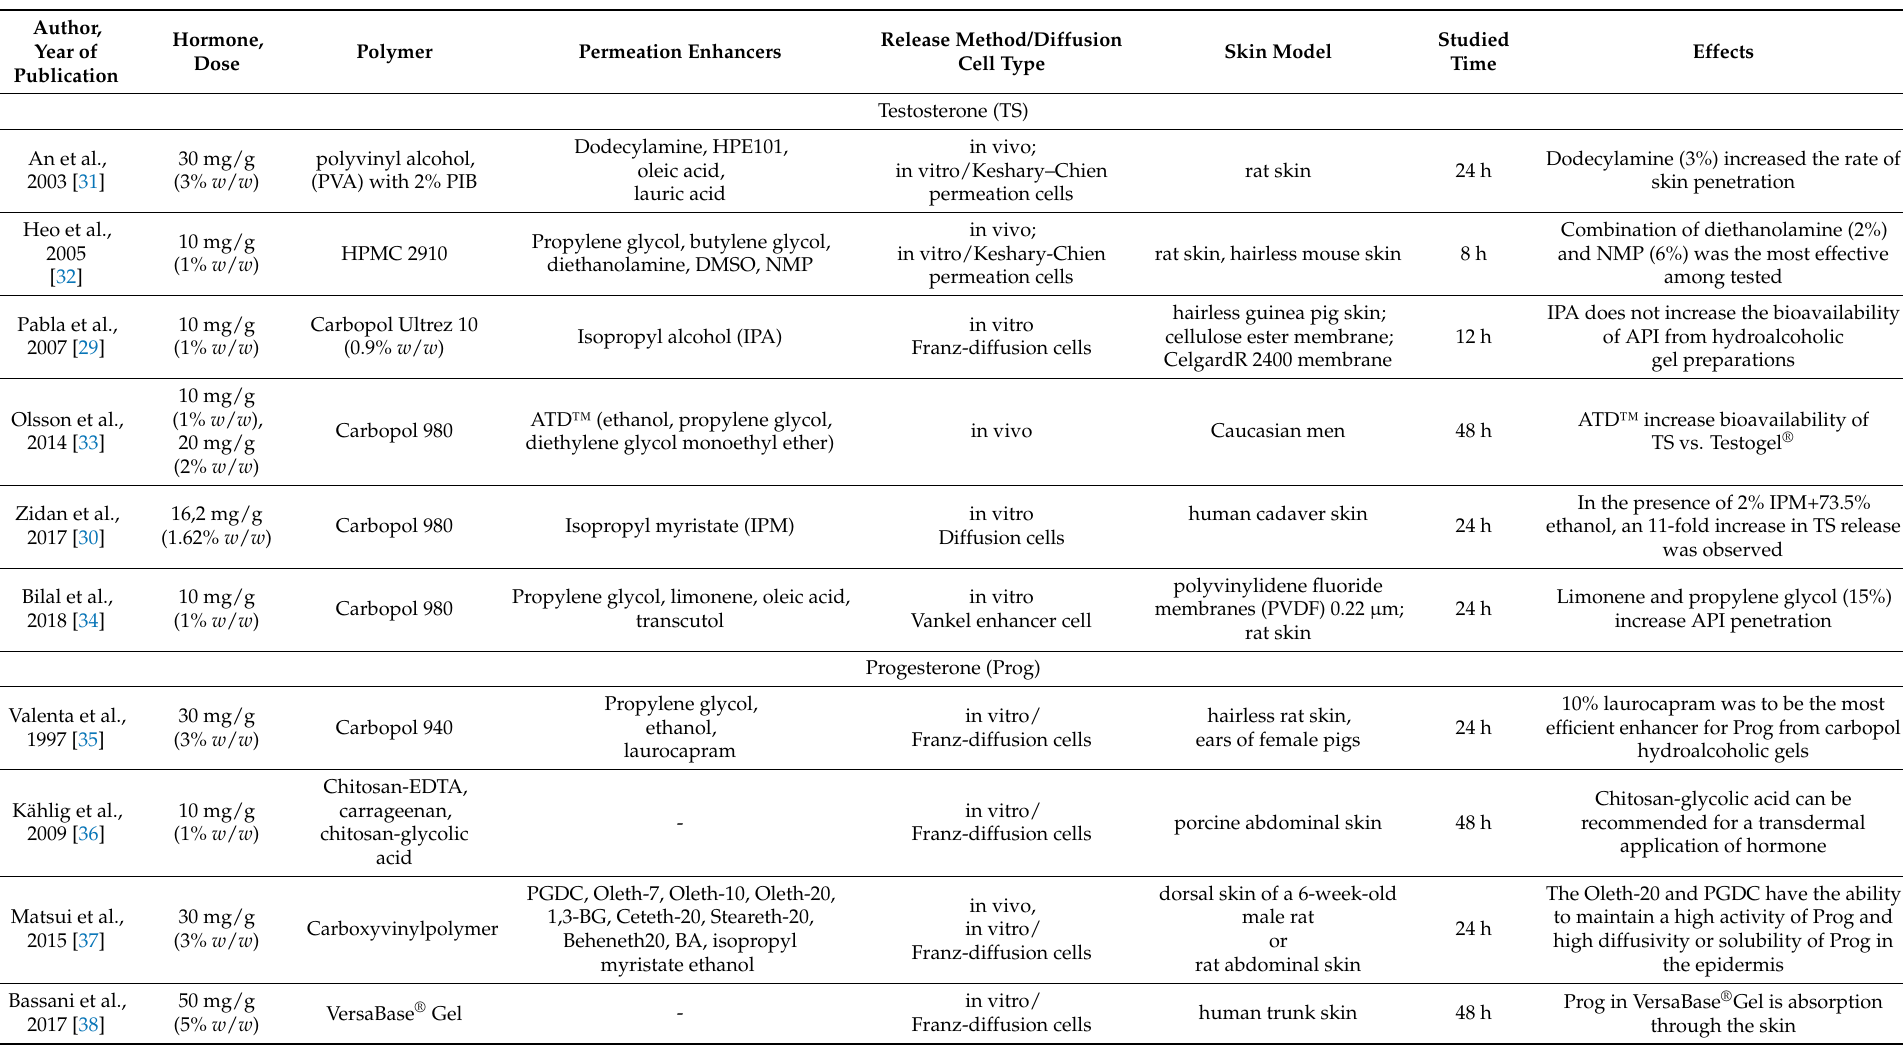
Table 1. Strategies used to incorporate the hormone into the